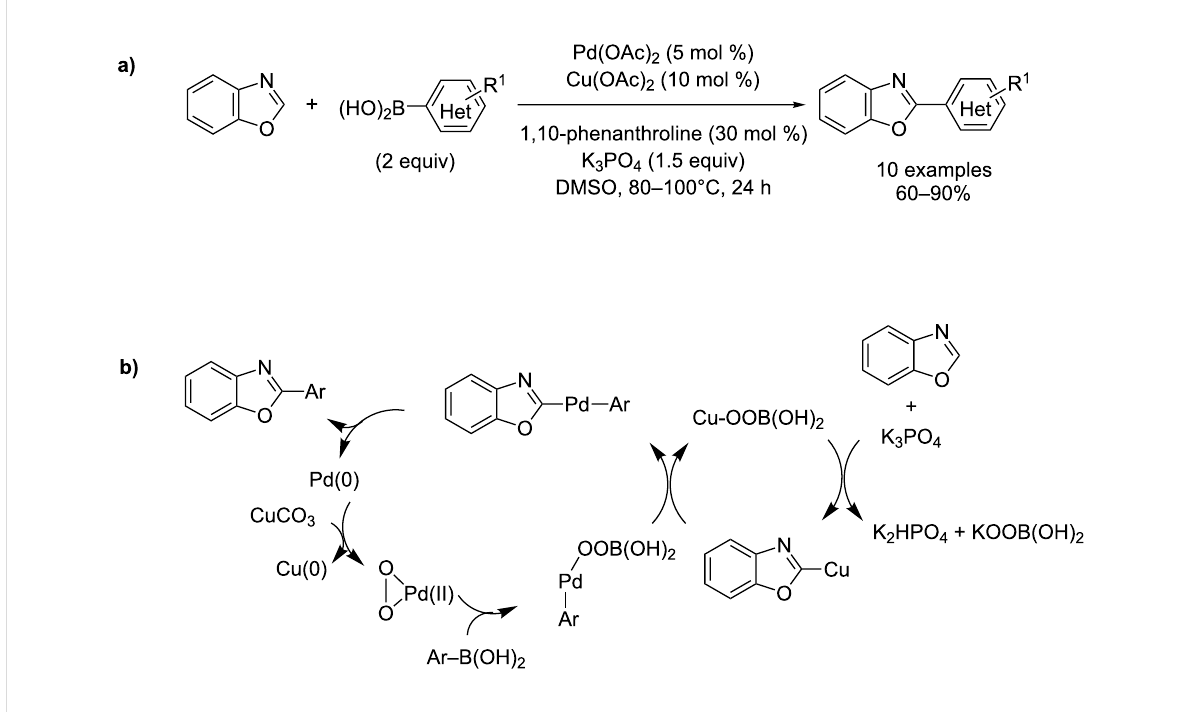
Scheme 27: Pd(II)- and Cu(II)-catalyzed direct arylation of benzoxazole with arylboronic acids [76]; (a) procedure; (b) proposed mechanism.